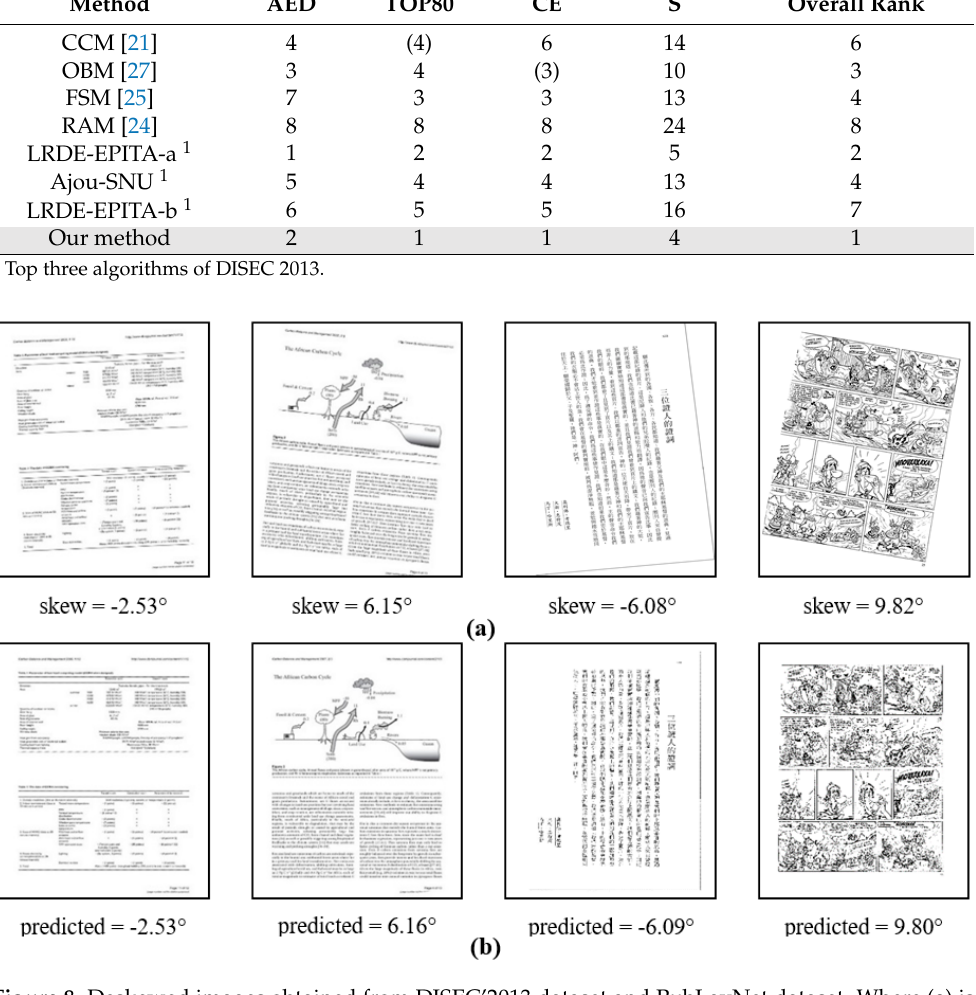
Figure 8. Deskewed images obtained from DISEC’2013 dataset and PubLayNet dataset. Where ( a ) is the original image and ( b ) is the image corrected by the algorithm proposed in this